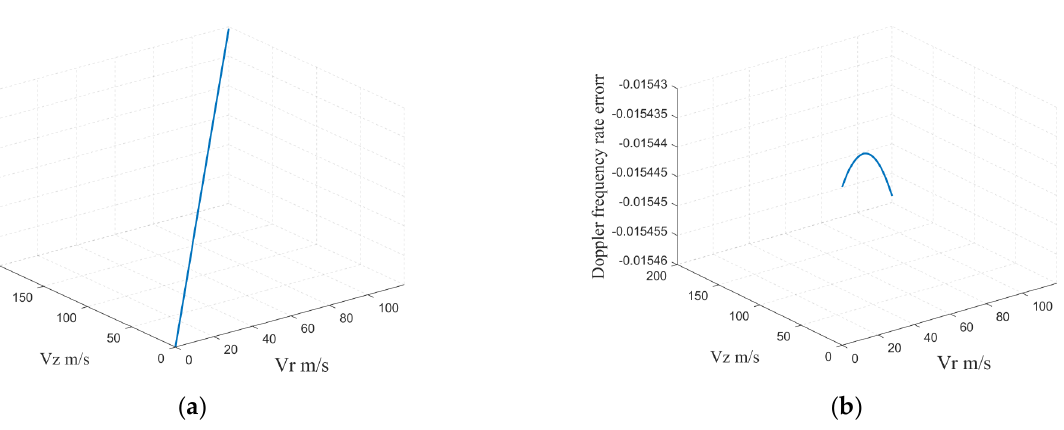
Figure 6. ( a ) Deviation of the Doppler centroid with the velocity between the 1st and 20th images; ( b ) deviation of the Doppler frequency rate with the velocity between the 1st and 20th images. For